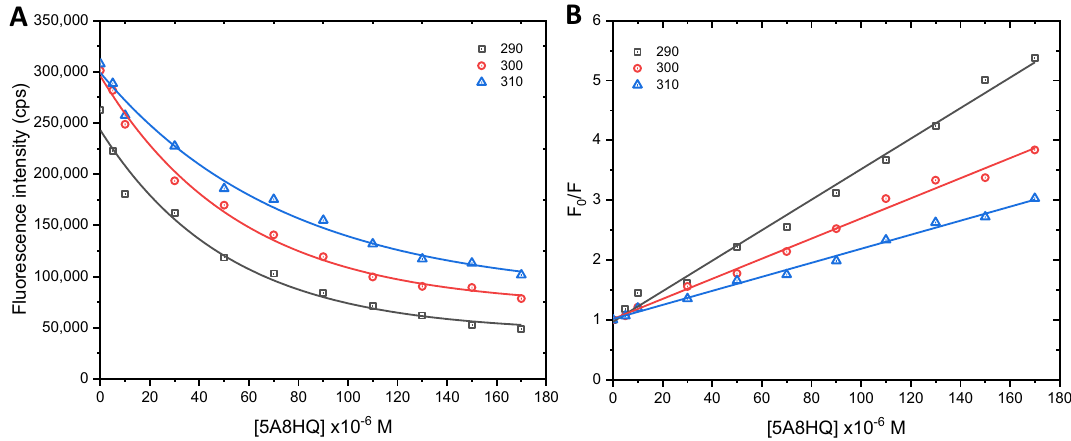
Figure 3. ( A ) Fluorescence quenching and ( B ) Stern–Volmer plots of BSA in the presence of 5A8HQ at 290, 300, and 310 K. [BSA] = 4 µM; [5A8HQ] = 0–170 µM; λ ex = 280 nm; λ em = 340 nm. T